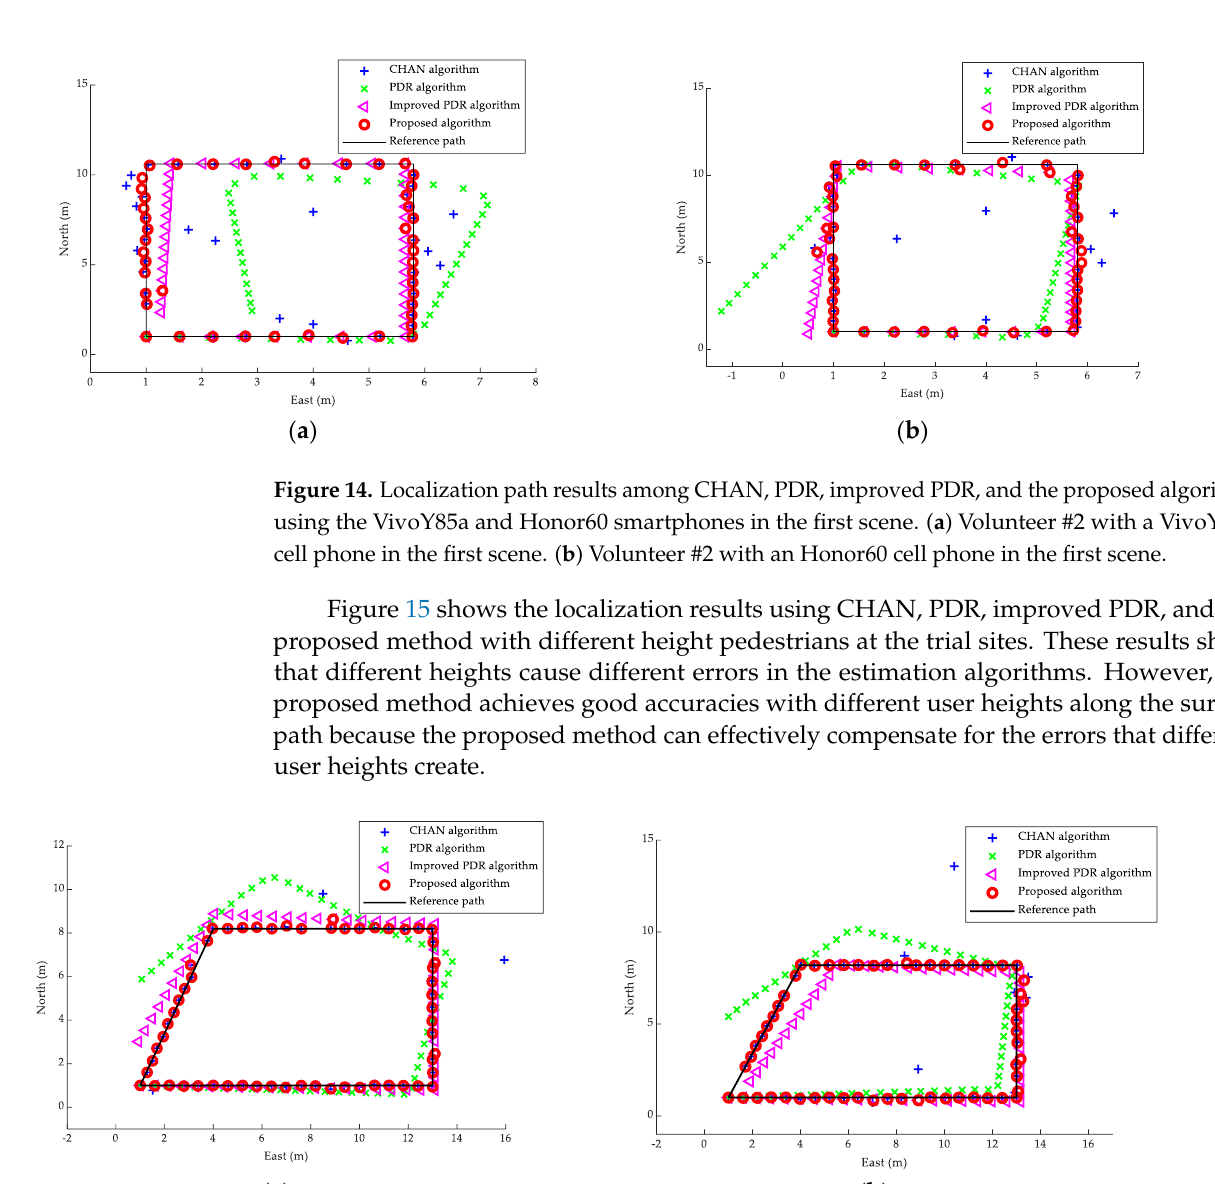
18 of 26 Figure 12. The CDF of localization errors between our PDR and PDR algorithms in the second scene. ( a ) Volunteer #1 with a VivoY85a cell phone. ( b ) Volunteer #2 with a VivoY85a cell phone. ( c ) Volunteer #1 with an Honor60 cell phone. ( d ) Volunteer #2 with an Honor60 cell phone. 5.3. Localization Performance We performed several experiments of localization performance on the global region at the two trial sites. Figure 13 shows the localization results using CHAN, PDR, improved PDR, and the proposed method at the two trial sites. These results show that the localiza- tion of the CHAN algorithm and the PDR algorithm is affected by the environment. Some abnormities occur in the acoustic localization, and cumulative errors occur over time in the PDR algorithm. However, the improved PDR algorithm and proposed algorithm can achieve better accuracy and effectively suppress the abnormity and cumulative errors. This result is attributed to the following reasons. First, the proposed PDR method can effectively extract accurate information to estimate location. In addition, we proposed er- ror judgment criteria to eliminate anomalous values. The proposed method thus exhibits good generality for different environments. ( a ) ( b ) Figure 13. Localization path results among CHAN, PDR, dynamic improved PDR, and the proposed algorithm at the two scenes. ( a ) Volunteer #1 with a VivoY85a cell phone in the first scene. ( b ) Vol- unteer #2 with a VivoY85a cell phone in the second scene. Figure 14 shows the localization results using CHAN, PDR, improved PDR, and the